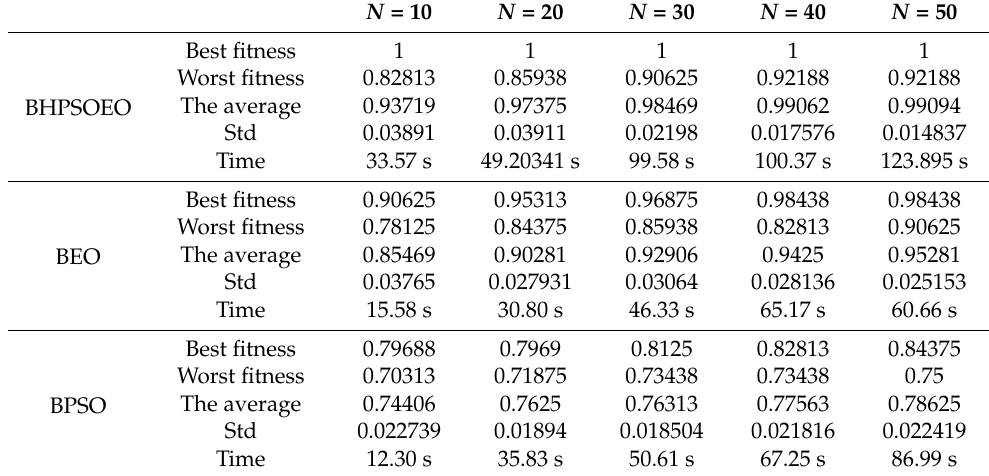
Table 1. BHPSEO, BEO and BPSO numerical results for cryptanalysis of RC4 cipher for a 64-bit text length.